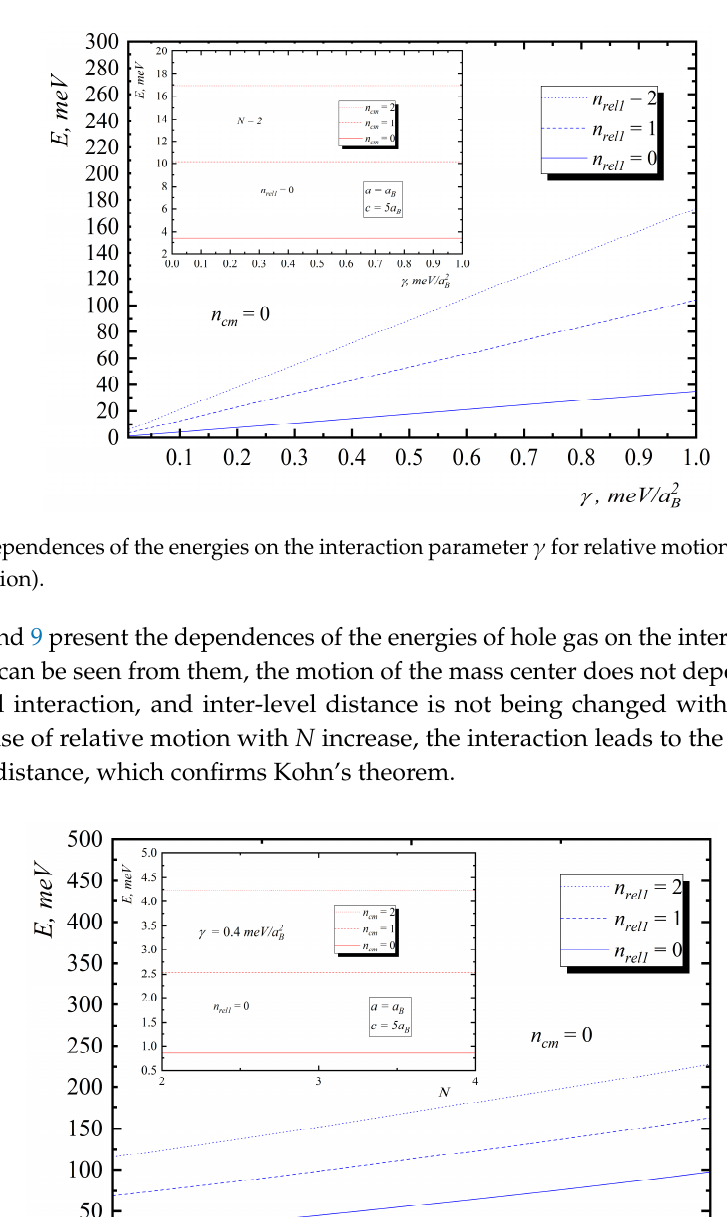
Figure 9. Dependences of the energies on the number of particles for relative motion (insert – center of mass motion).